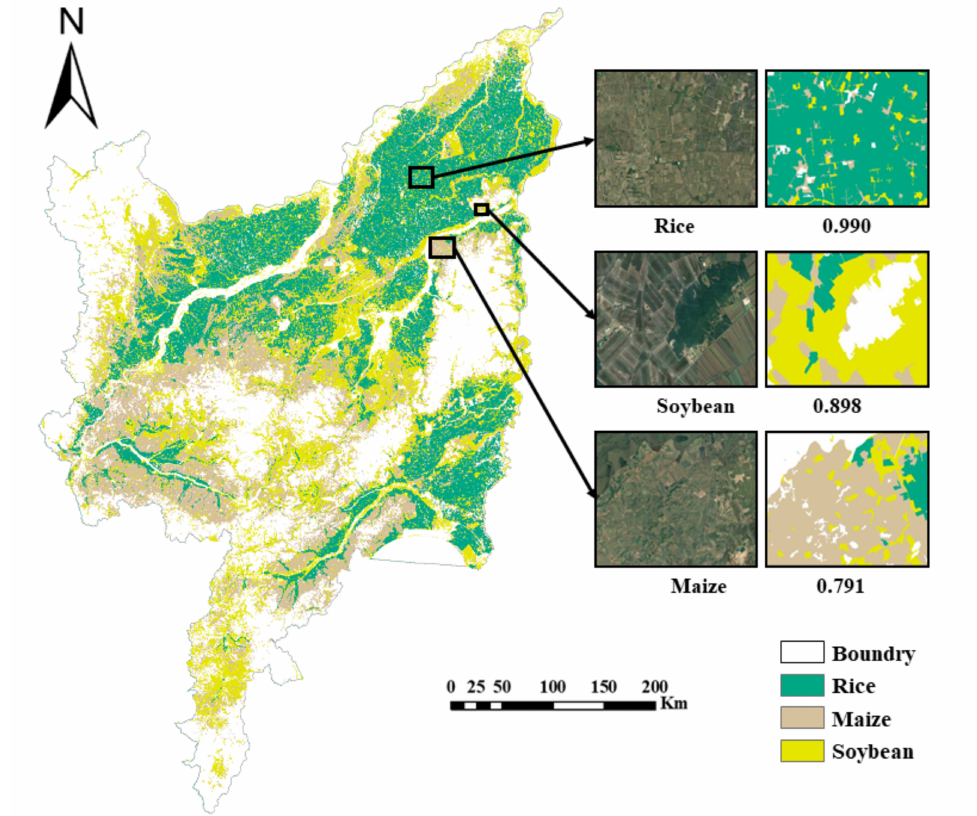
Figure 7. Classification map of three crops and partial enlarged